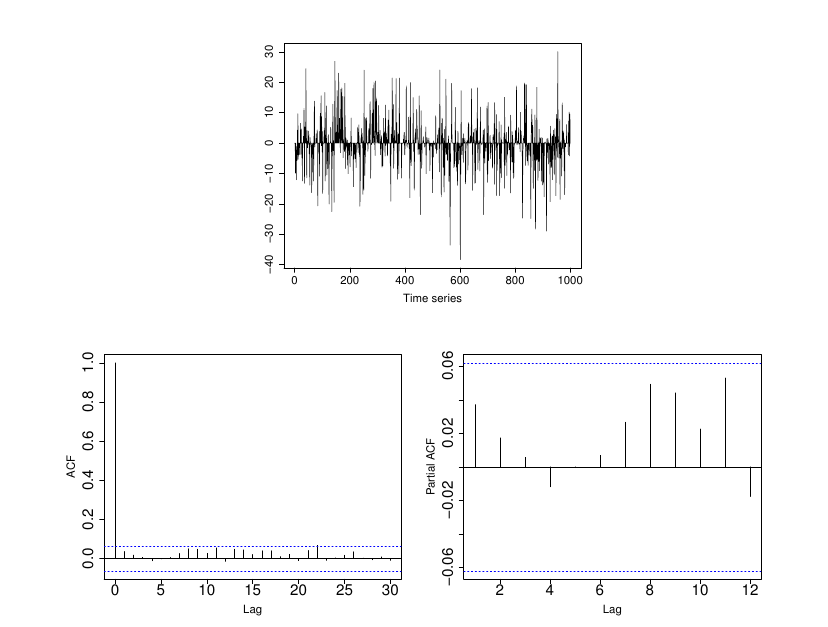
Figure 6 – Plots of residuals series and its ACF and